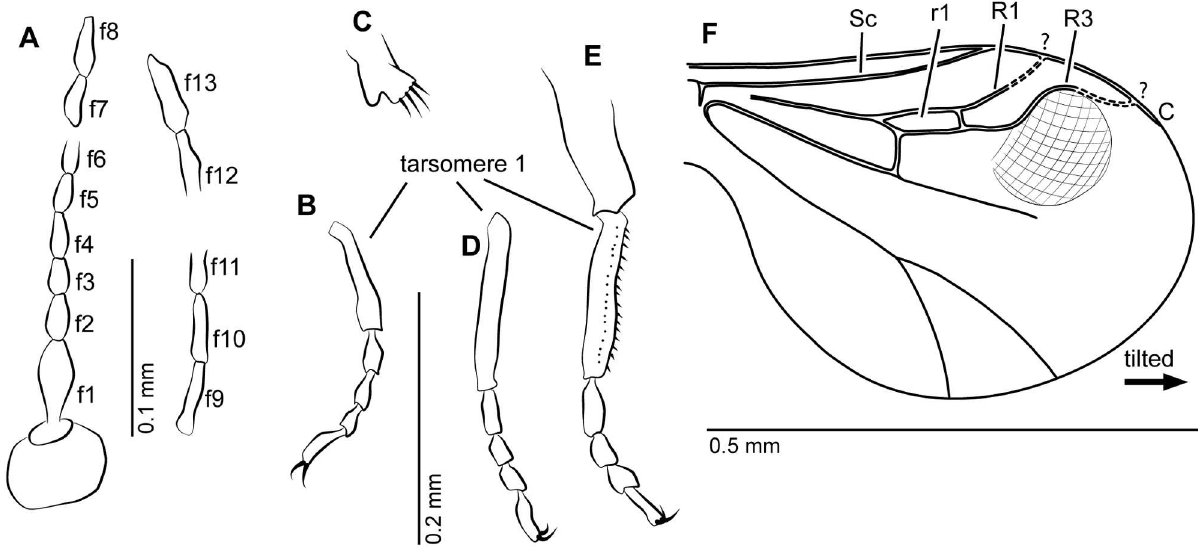
Fig 1. Female of Eohelea indica n. sp. from early Eocene Cambay amber, holotype female, no. Tad-855. A . Antenna, pediceland flagellomeres1–13 (f1-f13). B . Tarsus of fore leg. C . Tibial comb of hind leg. D . Tarsus of mid leg. E . Tibia and tarsus of hind leg. F .